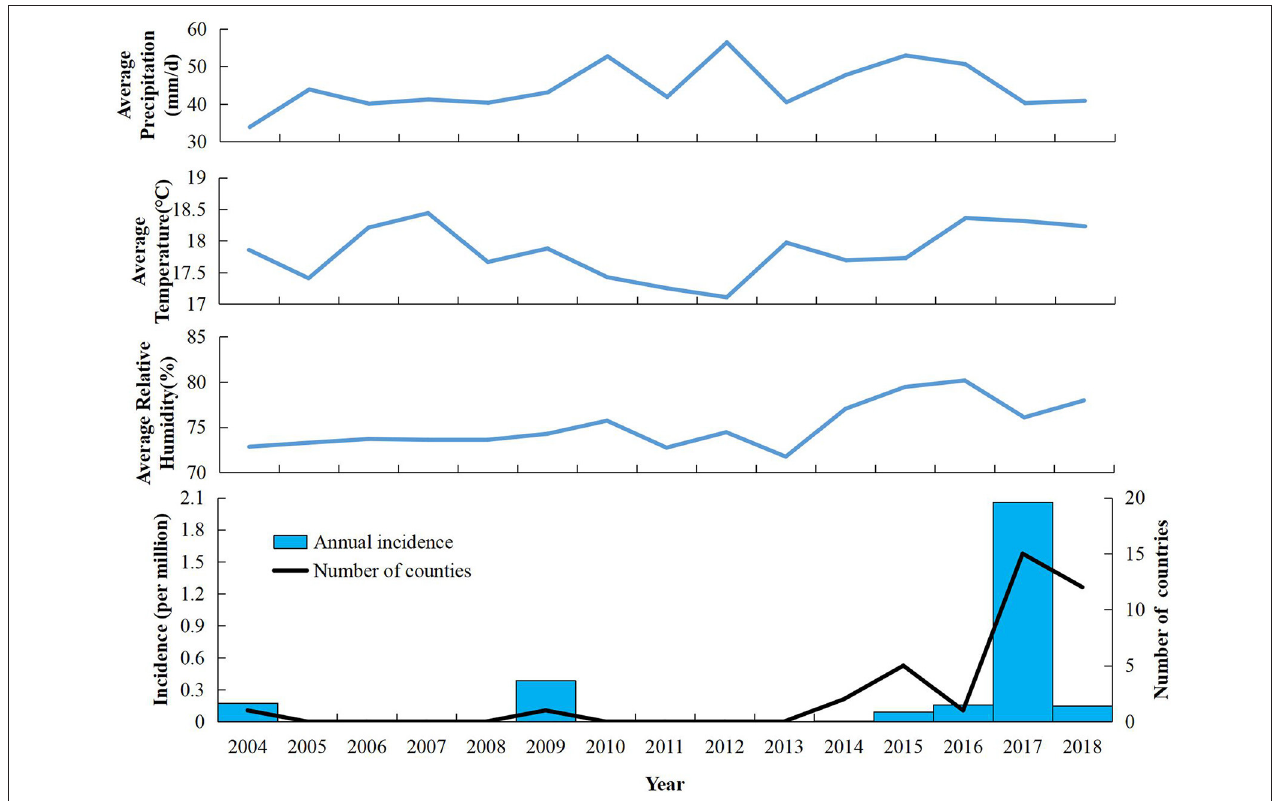
FIGURE 1 | Annual incidence, number of indigenous dengue cases, and meteorology in Zhejiang Province from 2004 to